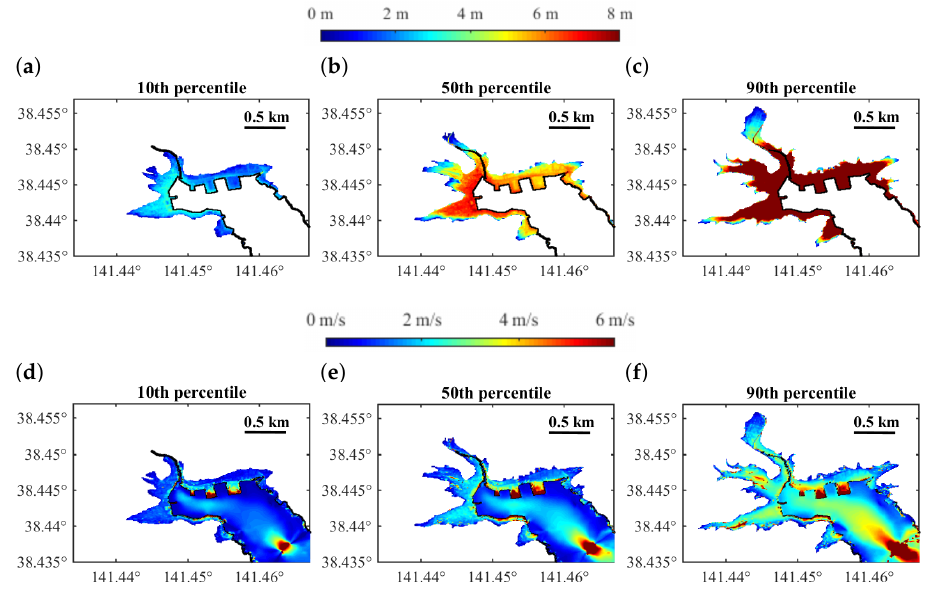
Figure 14. Stochastic tsunami hazard maps for region R1 in Onagawa: ( a – c ) inundation depth; and ( d – f ) flow